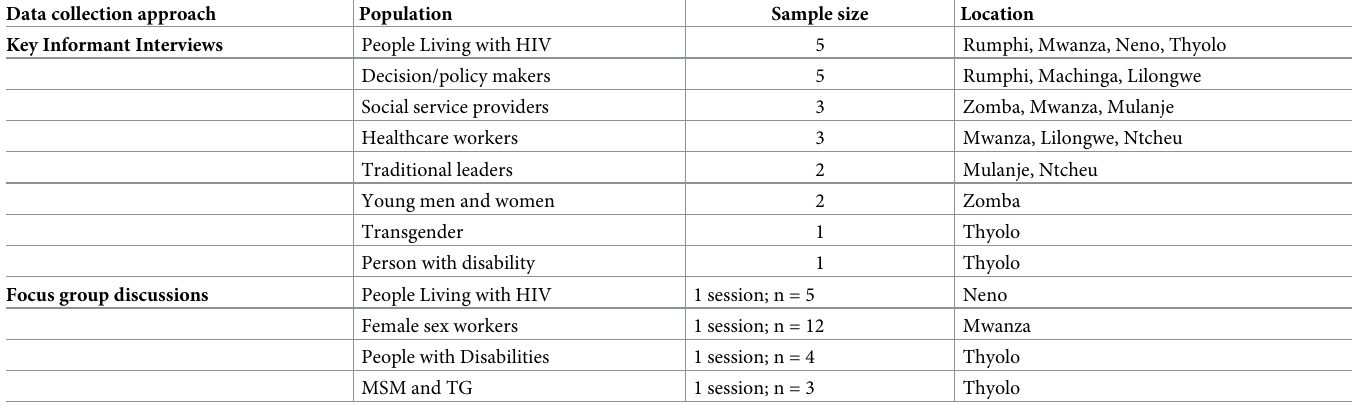
Table 1. Participant demographic